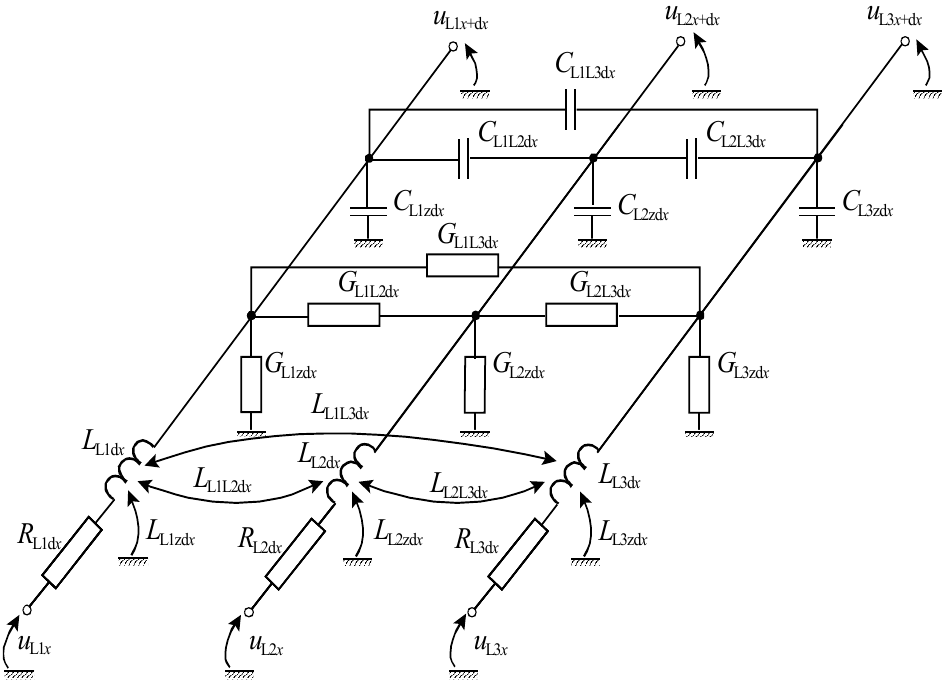
Figure 1. Model of the transmission line section with the length d x [12].